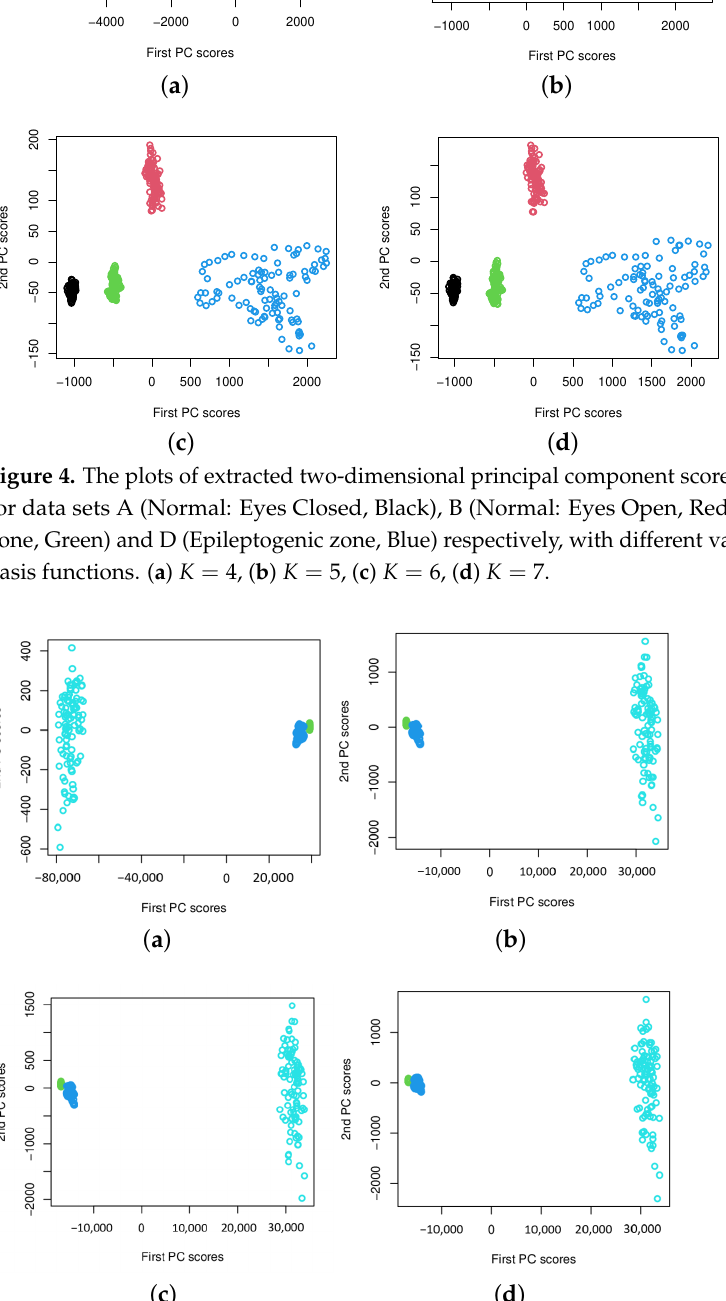
Figure 5. The plots of extracted two-dimensional principal component scores of DWT power spectra for data sets C (Non-epileptogenic zone, Green), D (Epileptogenic zone, Blue), and E (Seizure on set, Light Blue), respectively, with different values of K , the number of basis functions. ( a ) K = 4, ( b ) K = 5, ( c ) K = 6, ( d ) K =